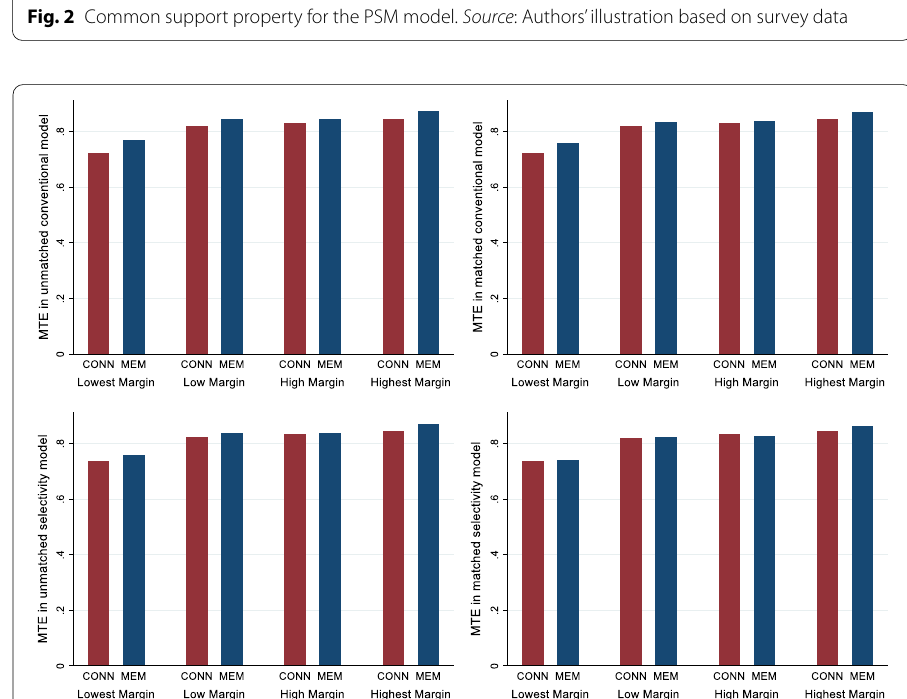
Fig. 3 Metafrontier efficiency scores based on shrimpers’ gross margin. Source : Authors’ illustration based on survey